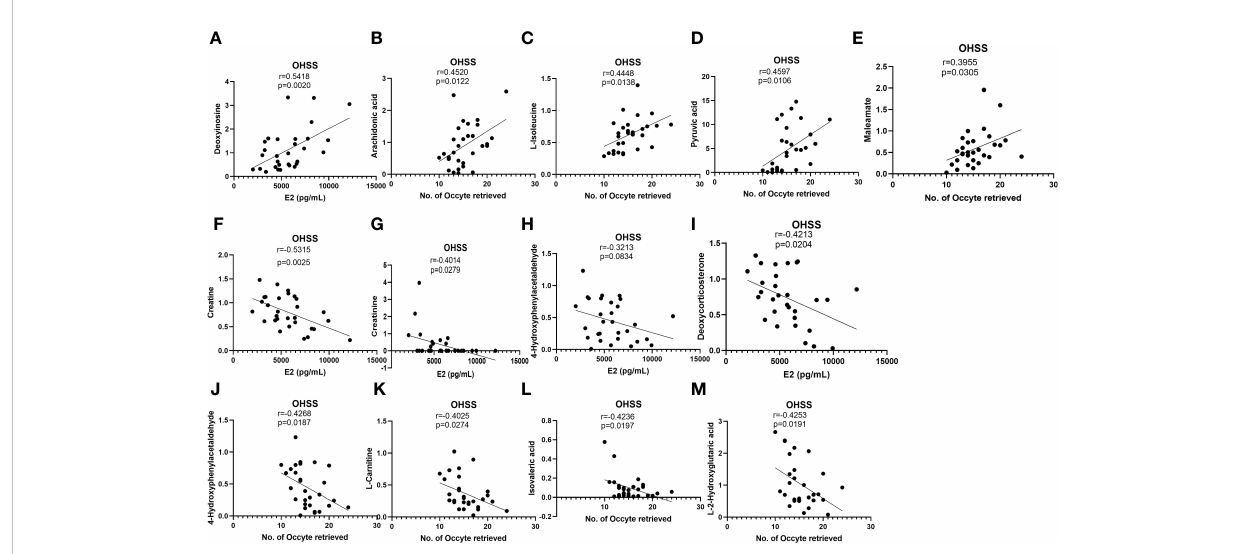
FIGURE 6 Correlation analyses between differentially changed metabolites and E2 or No. of oocytes retrieved in OHSS. (A) Deoxyinosine positively associated with E2 in OHSS. (B) arachidonic acid, (C) L-isoleucine, (D) pyruvic acid, and (E) maleamate positively associated with No. of oocytes retrieved in OHSS. (F) creatine, (G) creatinine, (H) 4-hydroxyphenylacetaldehyde, and (I) deoxycorticosterone negatively associated with E2 in OHSS. (J) 4- hydroxyphenylacetaldehyde, (K) L-carnitine, (L) isovaleric acid, and (M) L-2-hydroxyglutaric acid negatively associated with No. of oocytes retrieved in